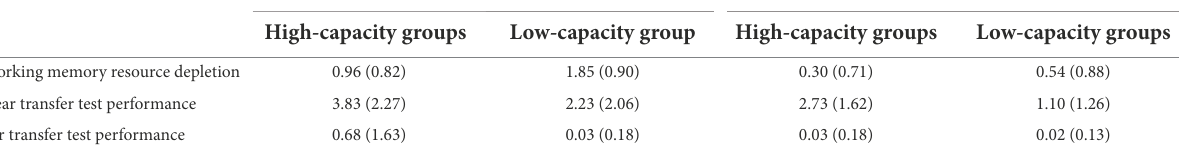
TABLE 2 Results (means and standard deviations) for the dependent variables of Experiment